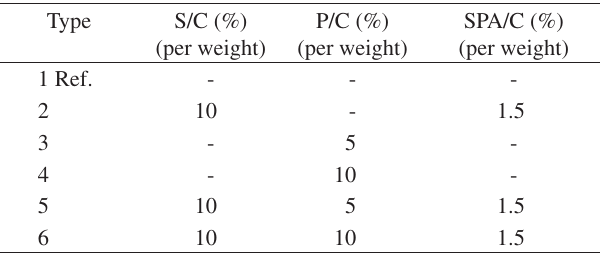
Table 1. Dosage of concretes. Type